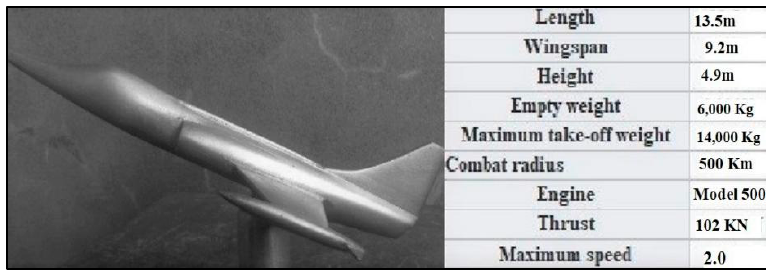
Figure 5. The application example when Figure 4a is replaced by a military image.